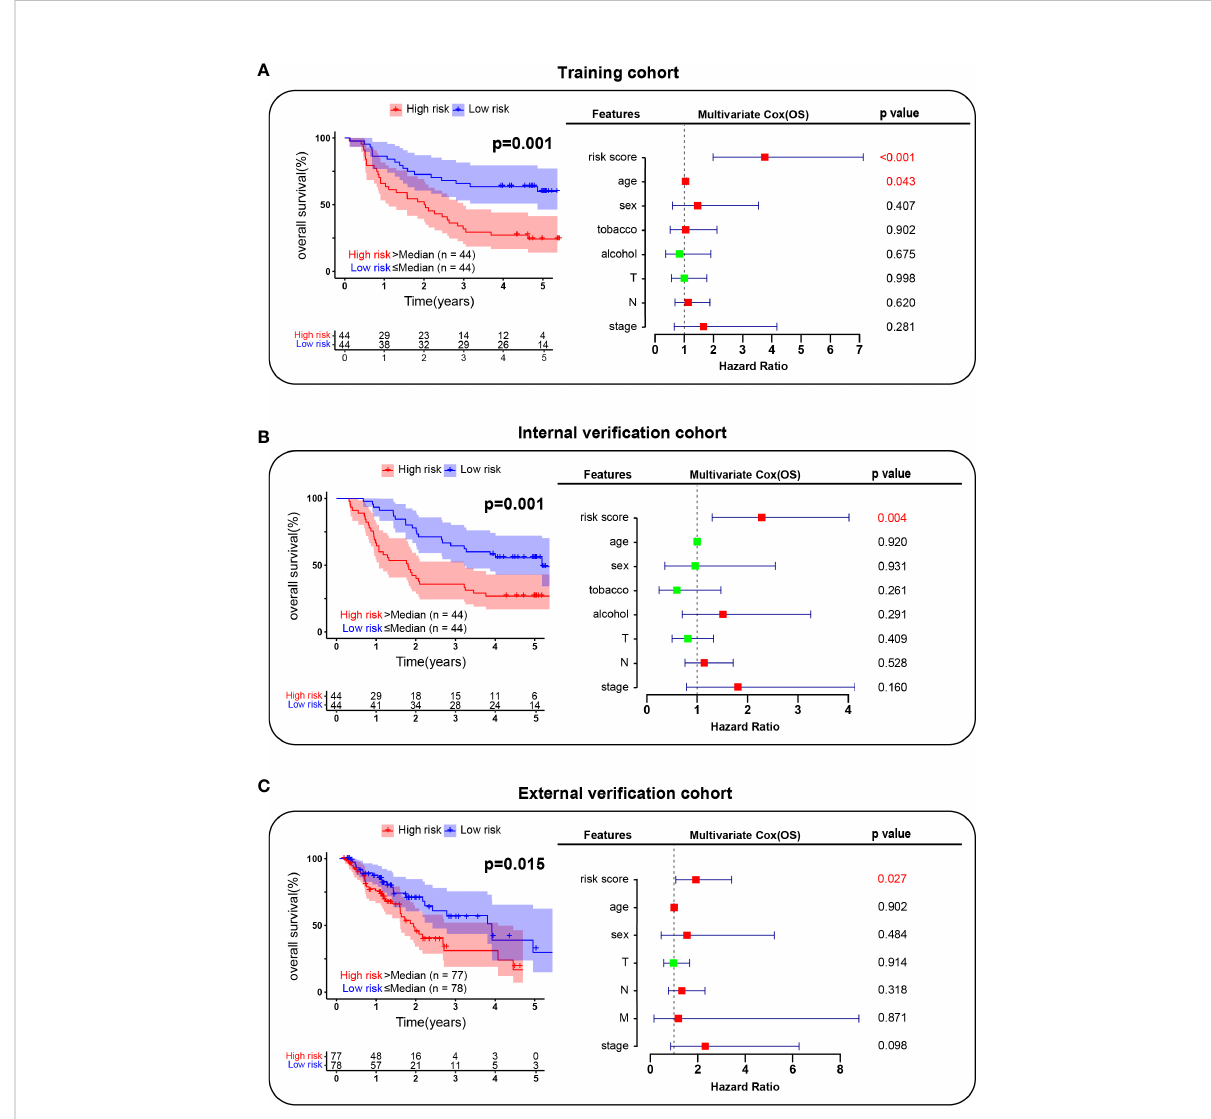
FIGURE 5 Risk regression model establishment. (A) . Survival analysis of patients in the training cohort. (B) . Survival analysis of patients in the internal veri fi cation cohort. (C) . Survival analysis of patients in the external veri fi cation cohort. The red box indicated the risk factor and the green indicated the protective